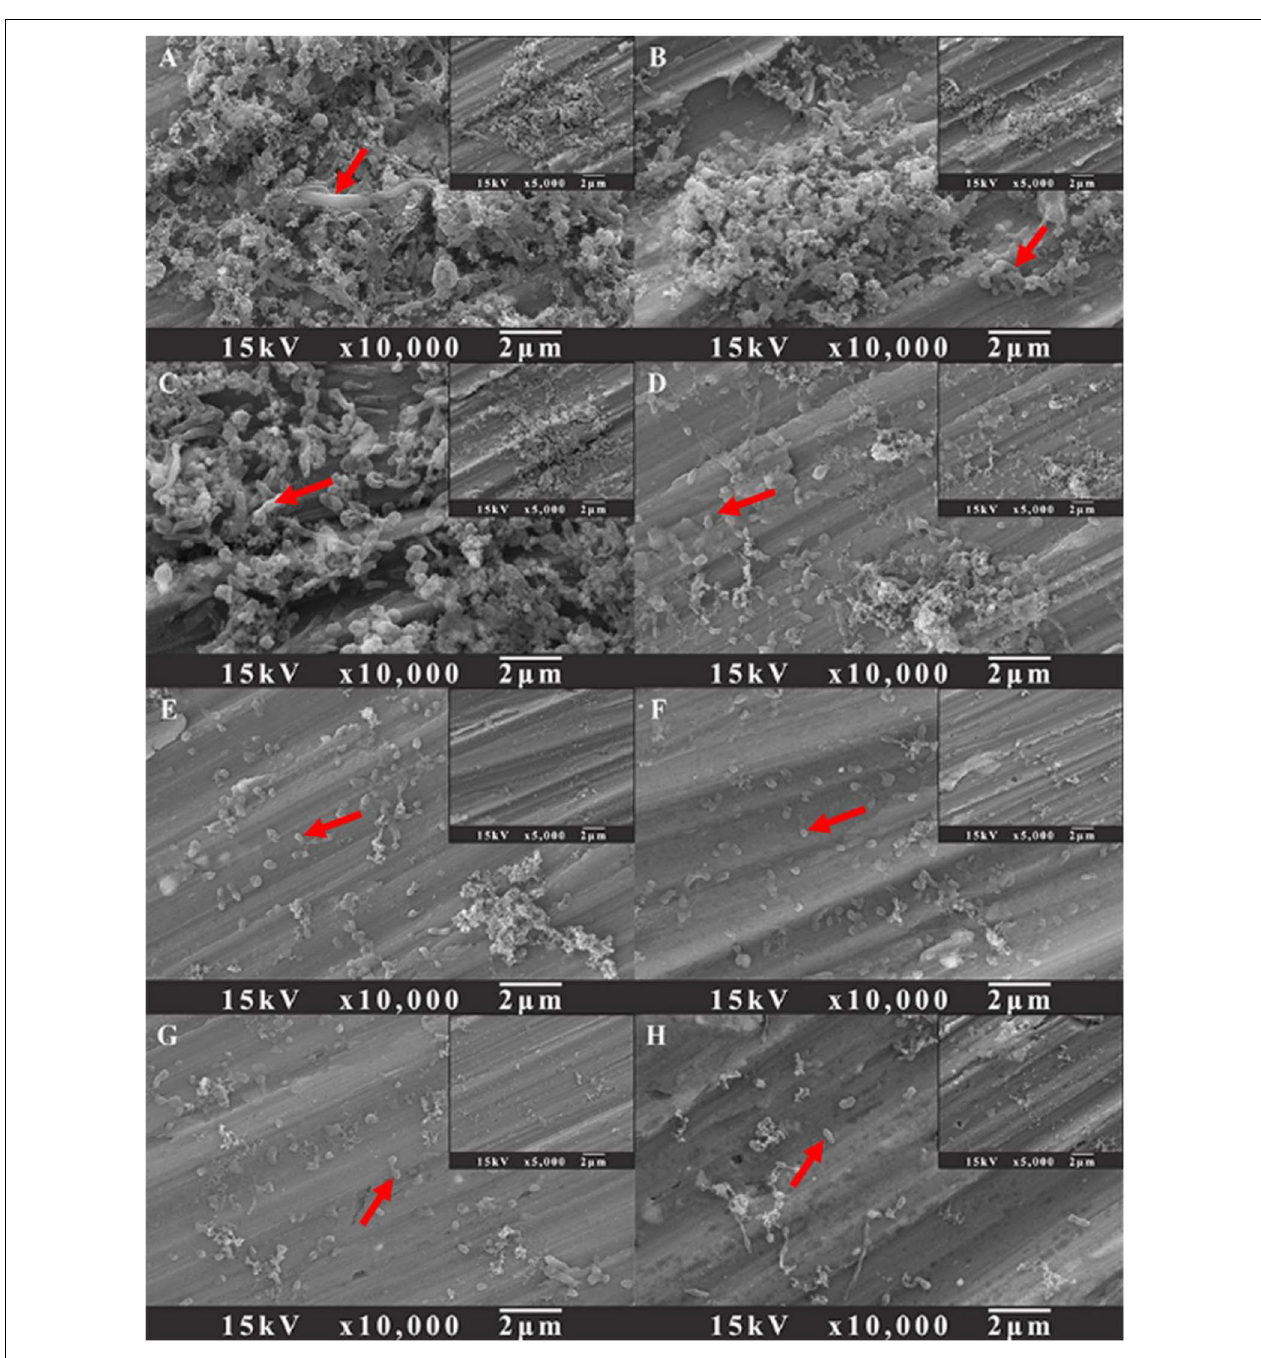
FIGURE 7 | SEM images of sessile cells after the 1-day biofilm removal test: (A) no treatment (control), (B) 1 ppm D -Tyr, (C) 100 ppm D -Met, (D) 5 ppm CMIT/MIT, (E) 5 ppm CMIT/MIT + 1 ppm D -Tyr, (F) 5 ppm CMIT + 100 ppm D -Met, (G) 5 ppm CMIT/MIT + 1 ppm D -Tyr + 100 ppm D -Met, and (H) 25 ppm CMIT/MIT. Red arrows indicate the bacterial cells attached on AA2024